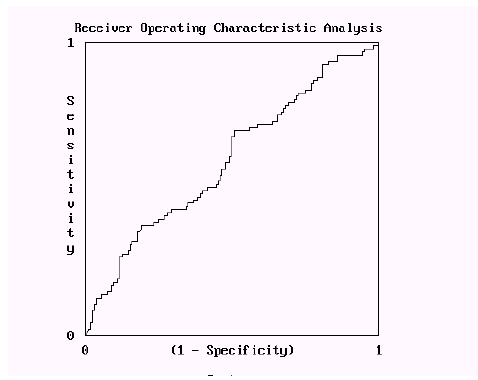
FIGURE 1B . ROC curve mortality within 365 days of discharge logistic regression. Test data: _____ AZ: 0.60.